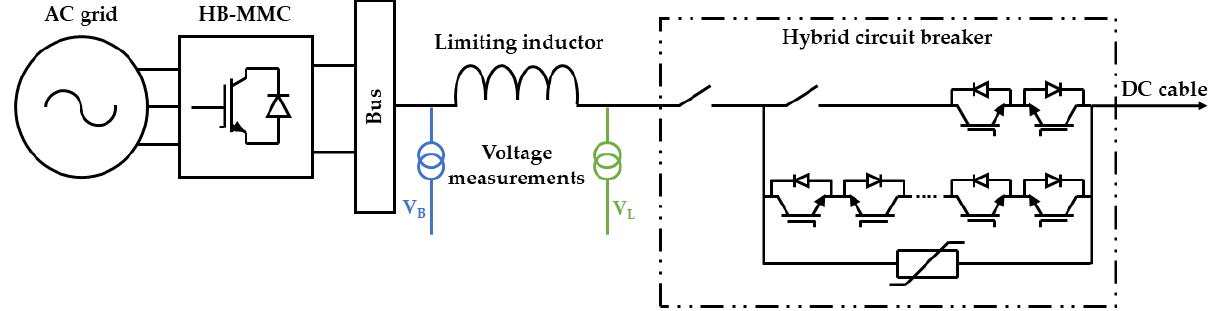
Figure 1. Diagram of the voltage measurements at both sides of the limiting inductor. These measurements are processed and their derivatives are calculated. Therefore, both primary and backup protections are based on the Rate-Of-Change-Of-Voltage